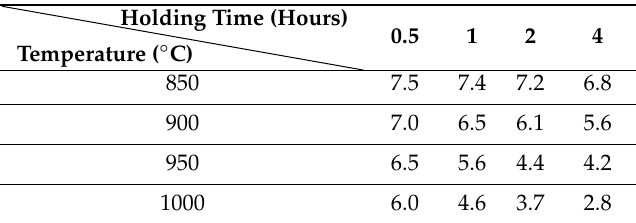
Table 2. Delta ferrite composition (%) of austenitic stainless steel at di ff erent temperatures and holding times [57].